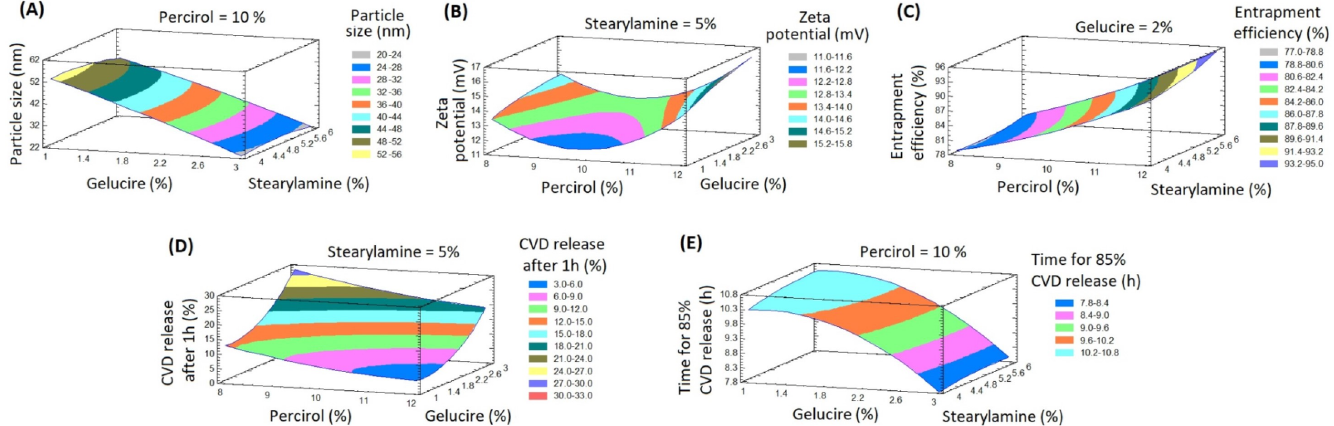
Fig 3. Estimated response surfaces with contour plots showing the effects of X 1 , X 2 , and X 3 on the dependent variables (Y 1 –Y 5 ).